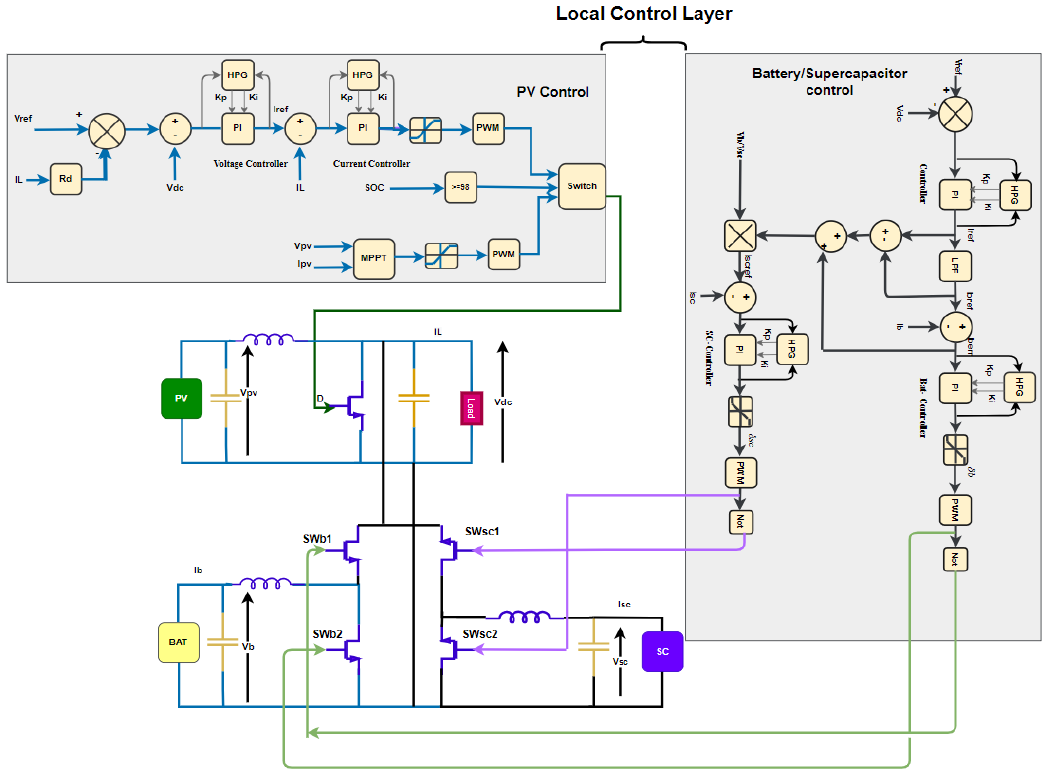
Figure 3. Proposed control method.